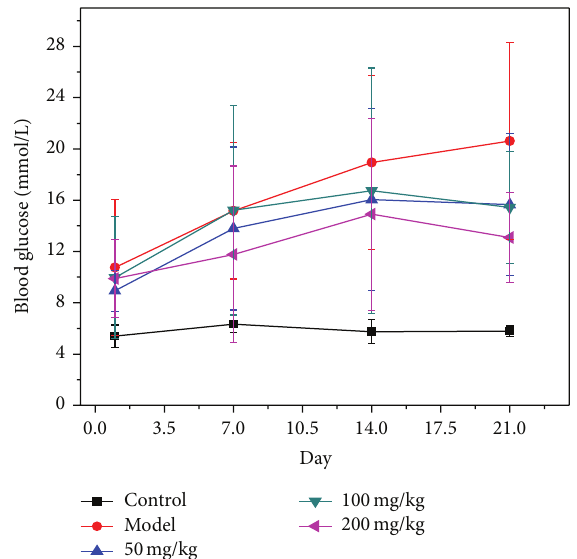
Figure 2: The effect of HuSang 32 branch bark extract on STZ- diabetic mice blood glucose level.